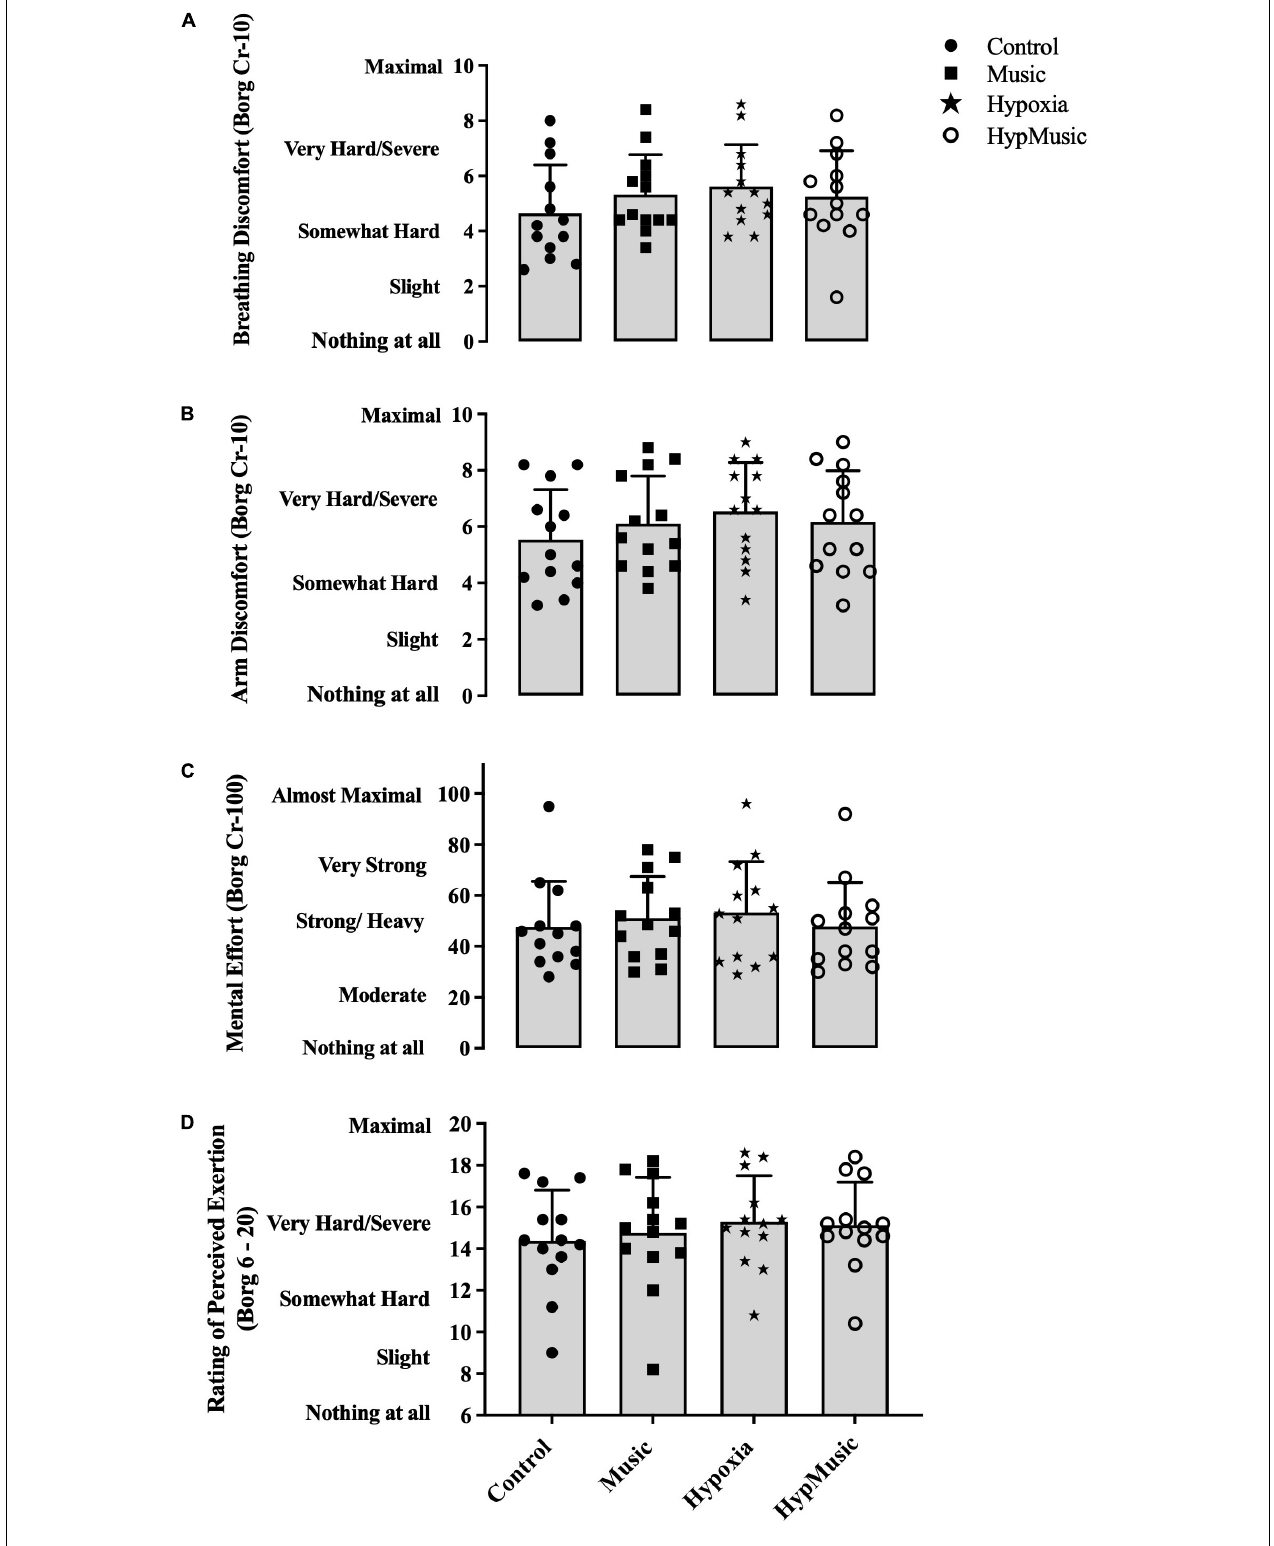
FIGURE 5 | Subjective ratings of (A) breathing discomfort (Borg CR-10 scale), (B) arm discomfort (Borg CR-10 scale), (C) mental effort (Borg CR-100 scale), and (D) rating of perceived exertion (Borg 6-20 scale). Data is averaged over the 15-min time trial.